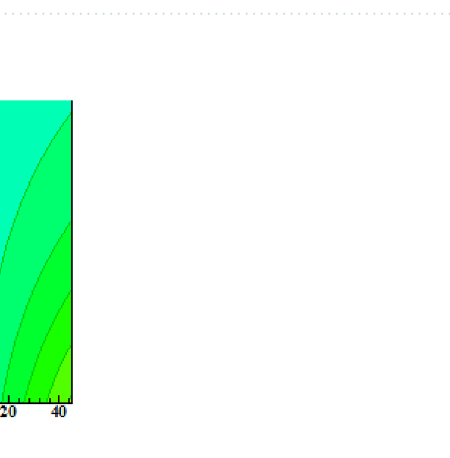
Figure 24. Contour plots of isotherms for when ( a ) Ha